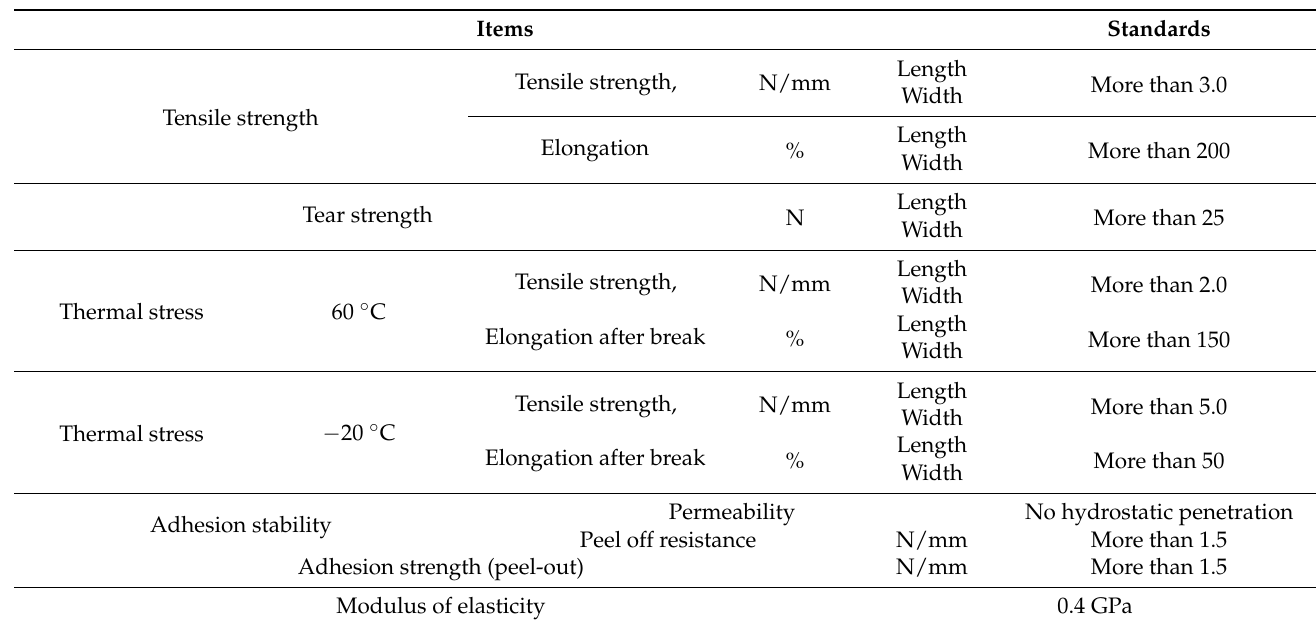
Table 2. Self-adhesive asphalt sheet (SAS)